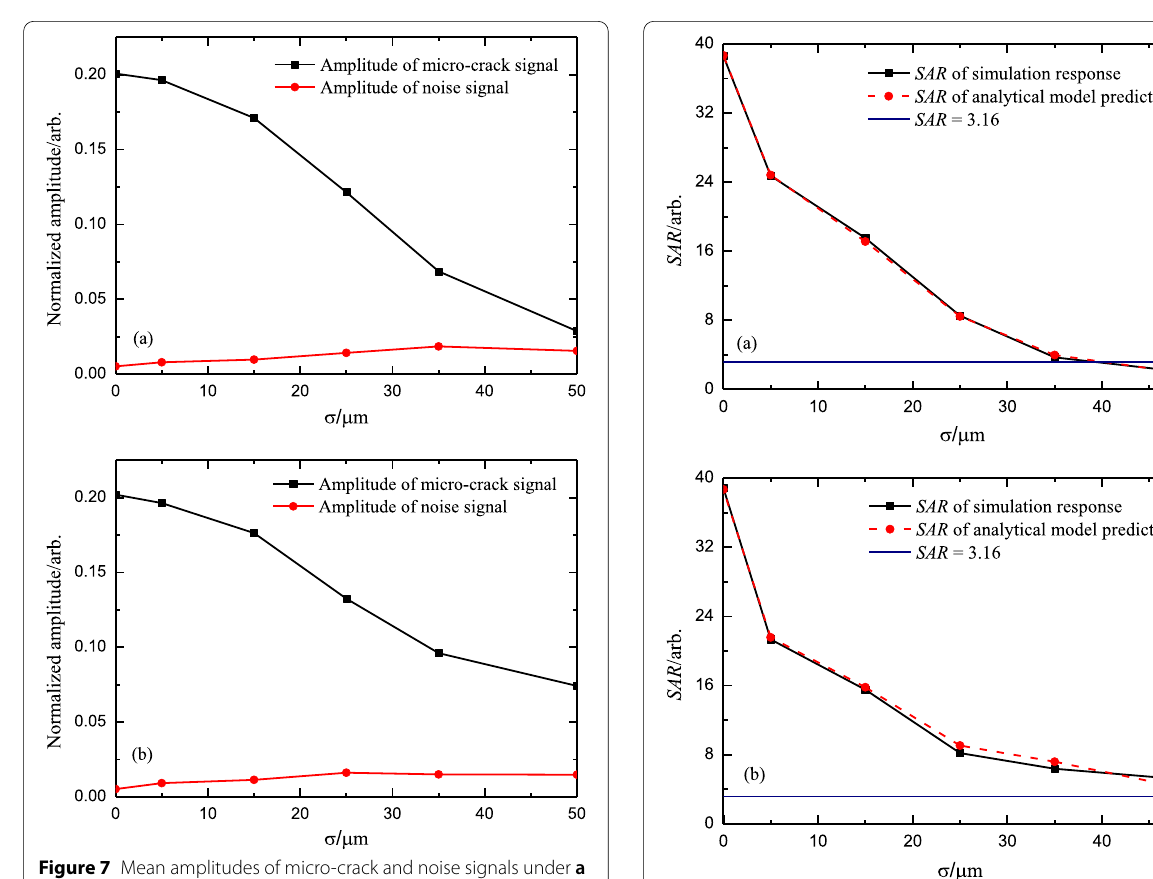
Figure 7 Mean amplitudes of micro-crack and noise signals under a rough front surfaces and b rough back surfaces in simulation mode Figure 8 Comparison of simulated responses SAR values with